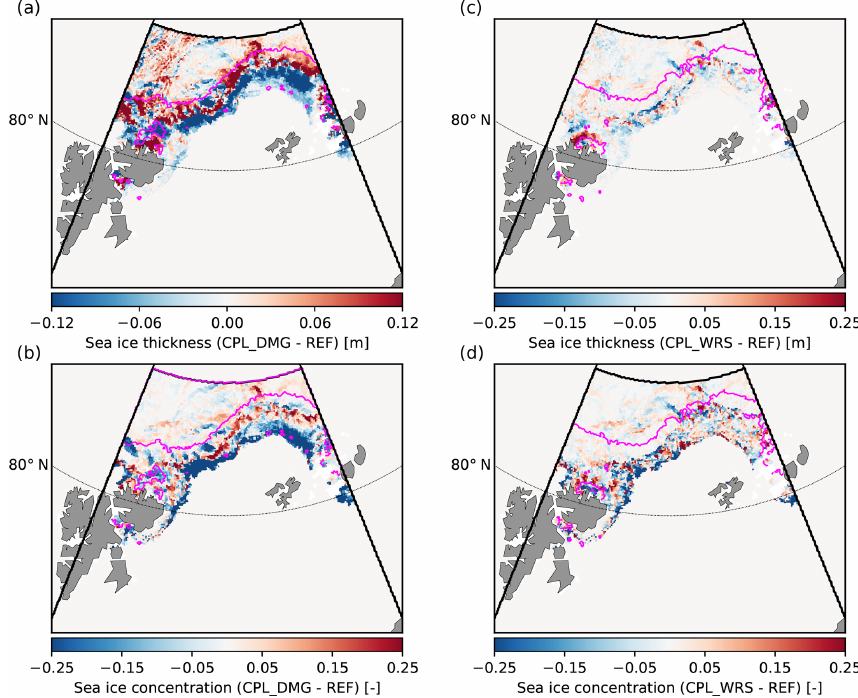
Figure 14. Snapshots of the distributions of difference in sea ice thickness (a, c) and sea ice concentration ( b, d) between the CPL_DMG and the REF simulations (a, b) and between the CPL_WRS and REF simulations (c, d) . All snapshots were taken on 21 October 2015 at 09:00:00GMT. The magenta line corresponds to the contour D max = 200m in CPL_DMG (a, b) and in CPL_WRS (c, d) . The black thick lines delimit the domain used to analyse the results from the three simulations (REF, CPL_WRS, CPL_DMG) in Figs. 9, 12 and